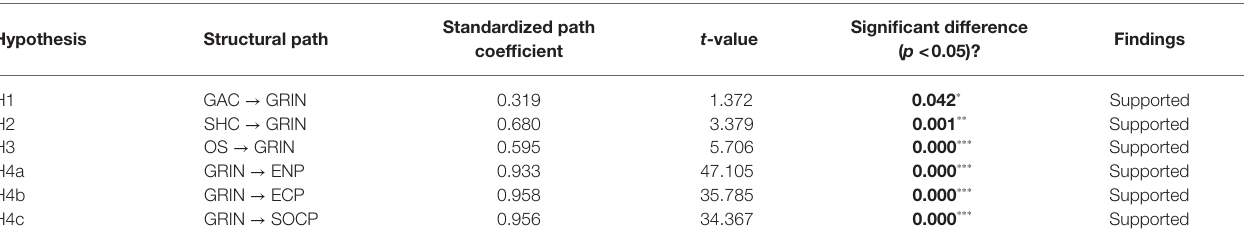
TABLE 4 | Hypothetical relationships. Hypothesis